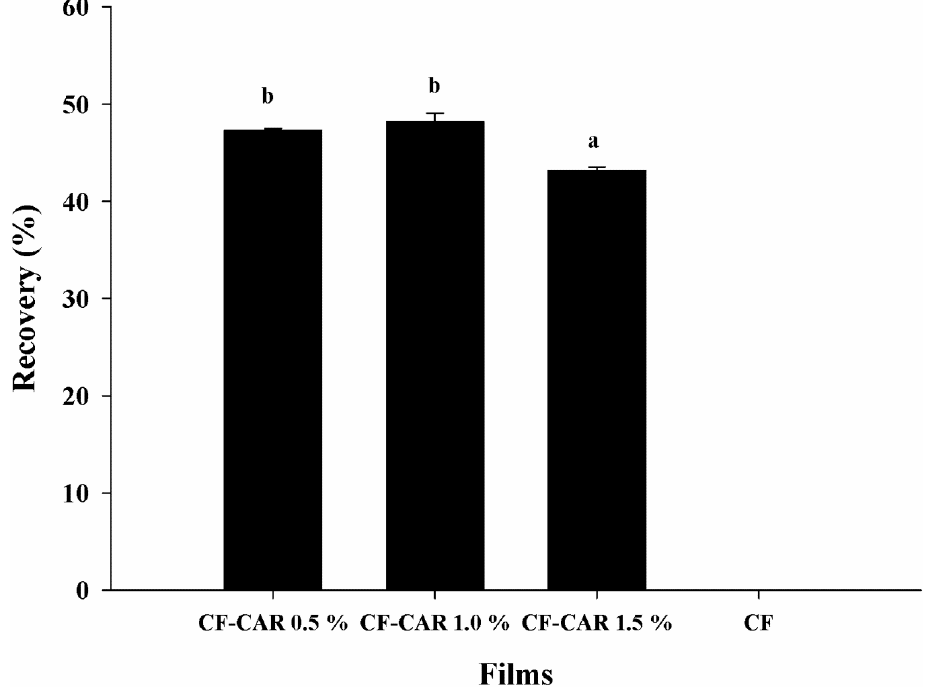
Figure 3. Percentage of CAR retention in the chitosan films. The data are the mean values of at least three determinations. The mean values represented by the bars for each type of films extract that are indicated with a different letter are significantly different ( p ≤